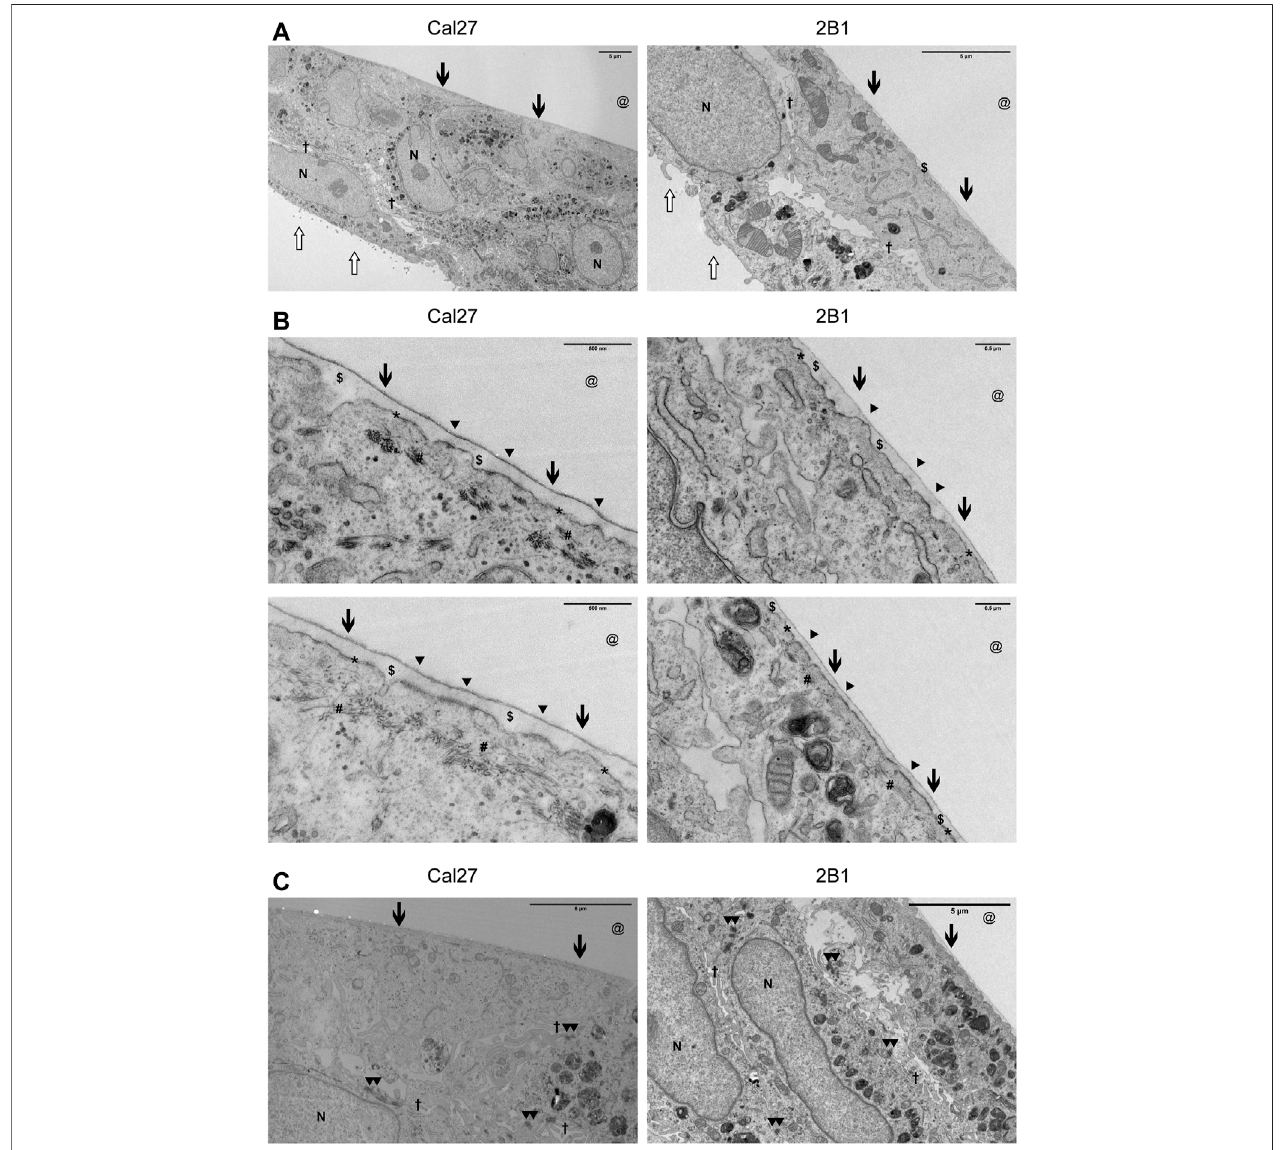
FIGURE4| Cal27and 2B1cellsform HD-likestructureswhichare indicative astype IIHDs. (A – C) Cal27 and 2B1cells werecultured on Aclar forupto7days and transverse sections of the cell-ECM interface were prepared, imaged by TEM, and a range of magni fi cations shown. (A) Lower magni fi cation images of cell monolayers thathaveformed a fl attened basalsurfacewithathinlayerofECM($)proximaltotheareawheretheAclar fi lm(@)wouldhaveoccupied. (B) Highermagni fi cationimages of the cell-ECM interface. Arrowheads ( ▲ ) indicate the approximate position of some type II HDs (indicated from the extracellular side) which are located at the plasmamembrane (*)andlinktocytoplasmiccytokeratin fi laments(#). (C) Areasofcellstoillustratetheformationofdesmosomes.Allimagesareorientatedwiththecell- ECM interface towards the top of the images. Other symbols used are [N (cid:2) nucleus; Open arrow (cid:2) luminal side with microvilli; Filled arrow (cid:2) basal surface next to ECM and aclar.; † (cid:2) cell-cell junction where you can sometimes see electron dense desmosomes ( ▲▲ ) as shown in (C) .